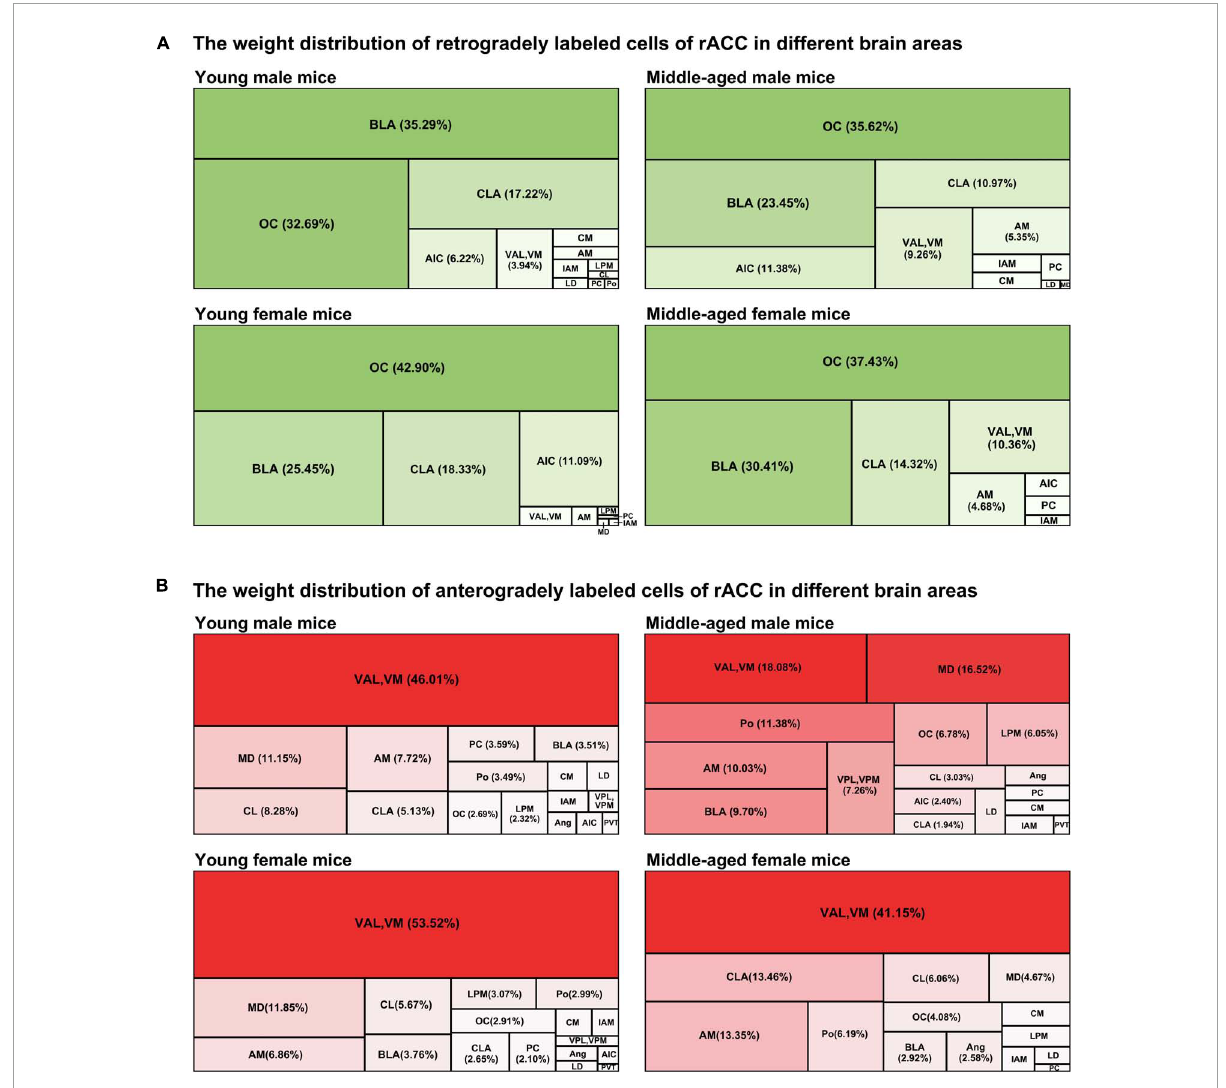
FIGURE4 The weight distribution of retrogradely and anterogradely labeled cells of the rACC in different brain regions. (A) The four tree maps indicate the weight distribution of retrogradely labeled cells of the rACC in different brain areas. (B) The four tree maps indicate the weight distribution of anterogradely labeled cells of the rACC in different brain areas.